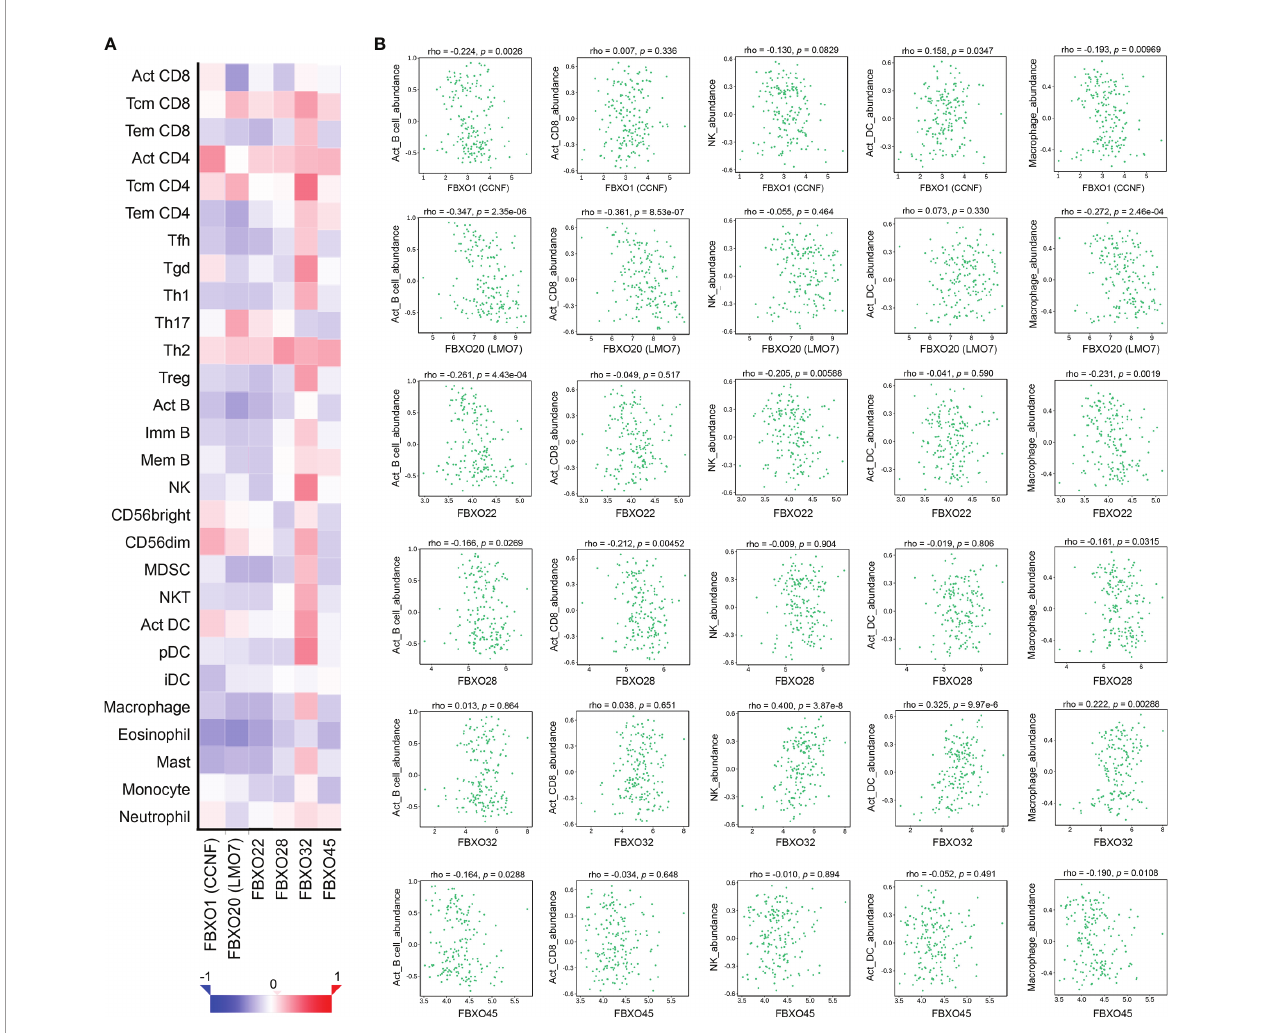
FIGURE 6 | Association of six-FBXO expression with immune in fi ltration level in pancreatic ductal adenocarcinoma (PDAC) (TISIDB). (A) Heat map of immune in fi ltrate correlation for six-FBXOs. (B) Scatter plot of the correlation between the expression level of six-FBXOs and immune cell in fi ltration, including Act_B cells, Act_CD8 + T cells, NK cells, Act_DC, macrophages (Spearman correlation, N = 179). Act, activated; NK, natural killer cells; DC, dendritic